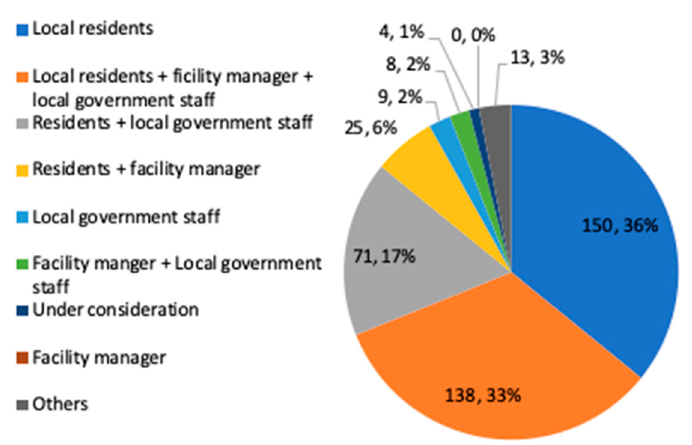
Figure 6. Shelter operating entity (single answer) (Single answer, total number of answers 418, total number of local governments: 418, unit: group).